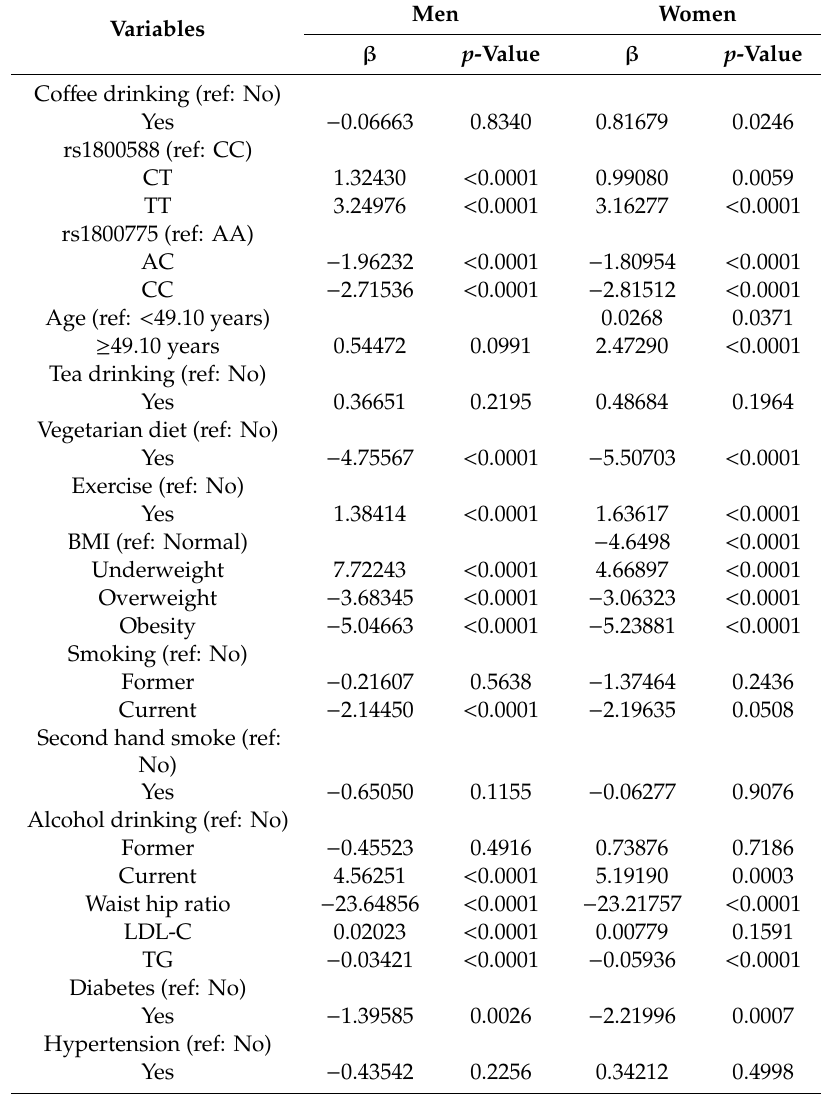
Table 3. Multiple linear regression showing the association between co ff ee drinking and HDL-C stratified by